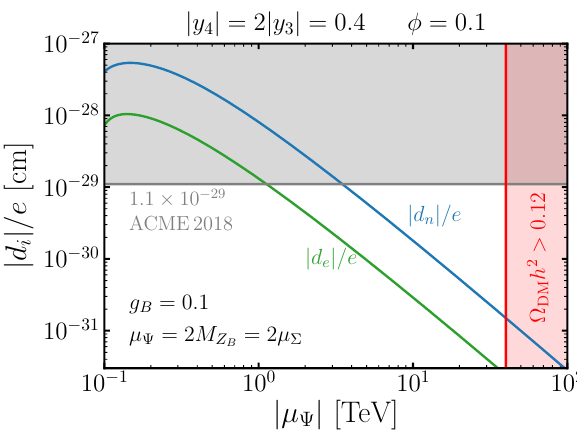
Figure 3 . Predictions for the EDMs as a function of the | µ Ψ | parameter. The blue (green) line corresponds to the EDM of the neutron (electron). The region shaded in gray is the upper limit on the electron EDM obtained by the ACME Collaboration [1]. The region shaded in light red corresponds to overproduction of dark matter. The Yukawa couplings and the mass parameters are fixed as shown in the figure. The CP-violating phase has been set to φ = arg( y ∗